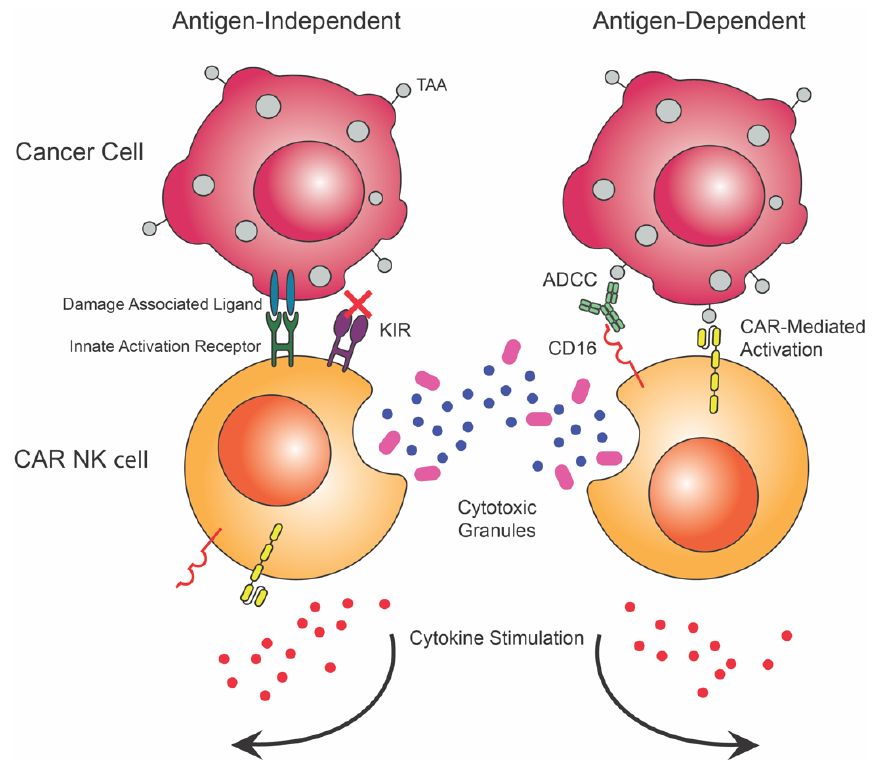
Figure 4. Natural killer CAR cell antigen independent and antigen dependent functions . Antigen-independent targeting of cancer is shown ( left ) through innate recognition. Antigen-dependent recognition is shown ( right ) through CAR recognition of TAAs. Antibody-dependent cellular cytotoxicity (ADCC) is also shown through binding of CD16 to tumor specific antibodies.